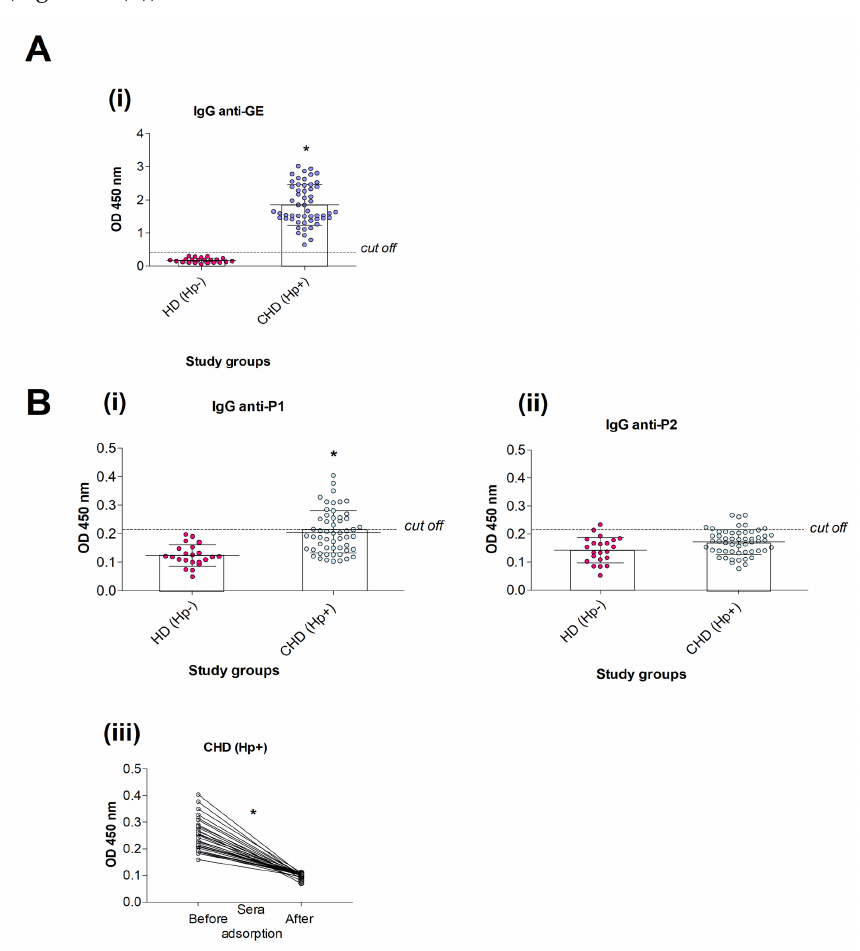
Figure 1. The prevalence and the level of antibodies in human sera. ( A ) IgG antibodies towards H. pylori glycine extract (GE) ( i ) Healthy donors (HD) seronegative for anti-GE IgG–HD Hp- (n = 22), patients with coronary heart disease (CHD) seropositive for anti-GE IgG–CHD Hp+ (n = 54); ( B ) anti-P1 IgG ( i ) and anti-P2 IgG ( ii ); the level of anti-P1 IgG before and after the adsorption of sera from CHD Hp+ patients with heat-inactivated H. pylori ( iii ). Shown are mean values ± standard deviation (SD). P1, synthetic peptide with the amino acid sequence (TVLLPLVIFF) present in human tumor necrosis factor receptor (TNFR); P2, control peptide (IAKEGFEKIS). The dot in the figure represents an individual data. Statistical significance: CHD(Hp+) vs. HD (Hp-) (Ai,Bi), CHD(Hp+) sera before vs. sera after adsorption with H. pylori , * p < 0.05. In order to link anti-P1 IgG production with H. pylori infection, we examined the presence of anti-P1 IgG in selected serum samples from CHD before and after the adsorption of serum samples with heat-killed H. pylori. The level of anti-P1 IgG was significantly diminished after the adsorption of sera with H. pylori (Figure 1B(iii)).